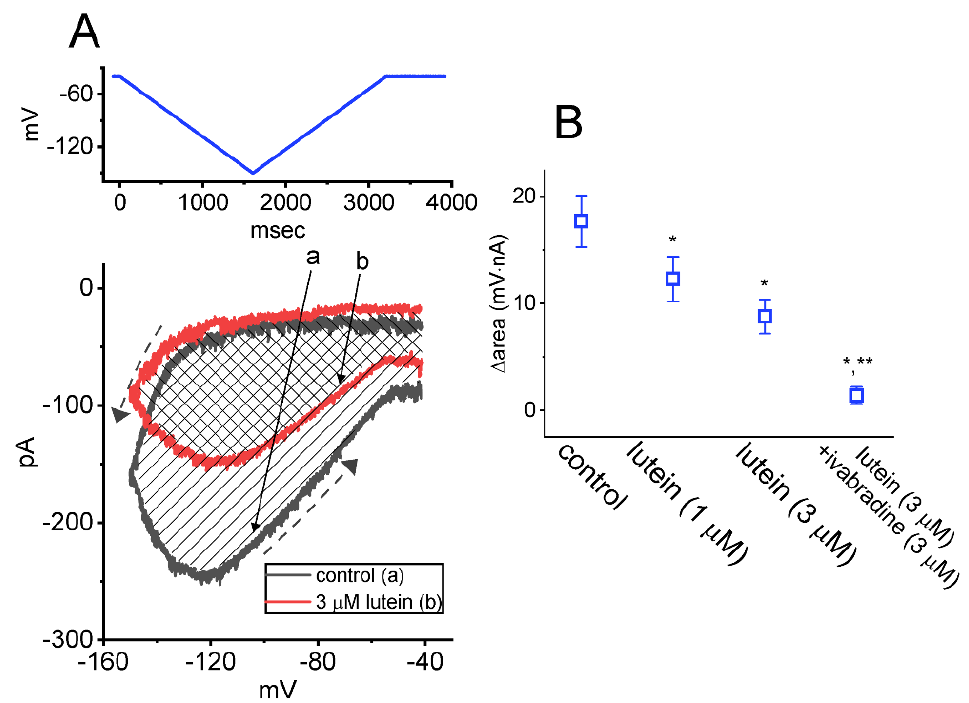
Figure 4. Modification by lutein on the strength in voltage-dependent hysteresis (Hys (V) ) of I h recorded from GH 3 cells. ( A ) Representative Hys (V) traces (i.e., the relationship of forward [descending] or reverse [ascending] current versus membrane potential) of I h evoked by the inverted double (i.e., isosceles-triangular) V ramp (indicated in the top part, blue color) in the absence (black color, a) or presence of 3 μM lutein (red color, b). The dashed black arrows along the current trace in the control period (i.e., lutein was not present) indicate an anti-clockwise direction of I h trajectory in which time passes with the activation by inverted triangular V ramp , while the shaded region is the Hys (V) area (∆area) with or without the lutein existence. ( B ) Summary graph revealing effects of lutein (1 or 3 μM) and lutein (3 μM) plus ivabradine (3 μM) on the ∆area of Hys (V) (i.e., the shaded region under the curve activated during the downsloping and upsloping ends of triangular V ramp ) of I h (mean ± SEM; n = 7 for each point). Of note, there was an emergence of V ramp -induced Hys (V) for I h elicitation, and the presence of lutein was concentration-dependently able to produce a measurable reduction in the Hys (V) ’s ∆area of the current. * Significantly different from control ( p < 0.05) and ** significantly different from lutein-alone (3 μM) group ( p < 0.05).